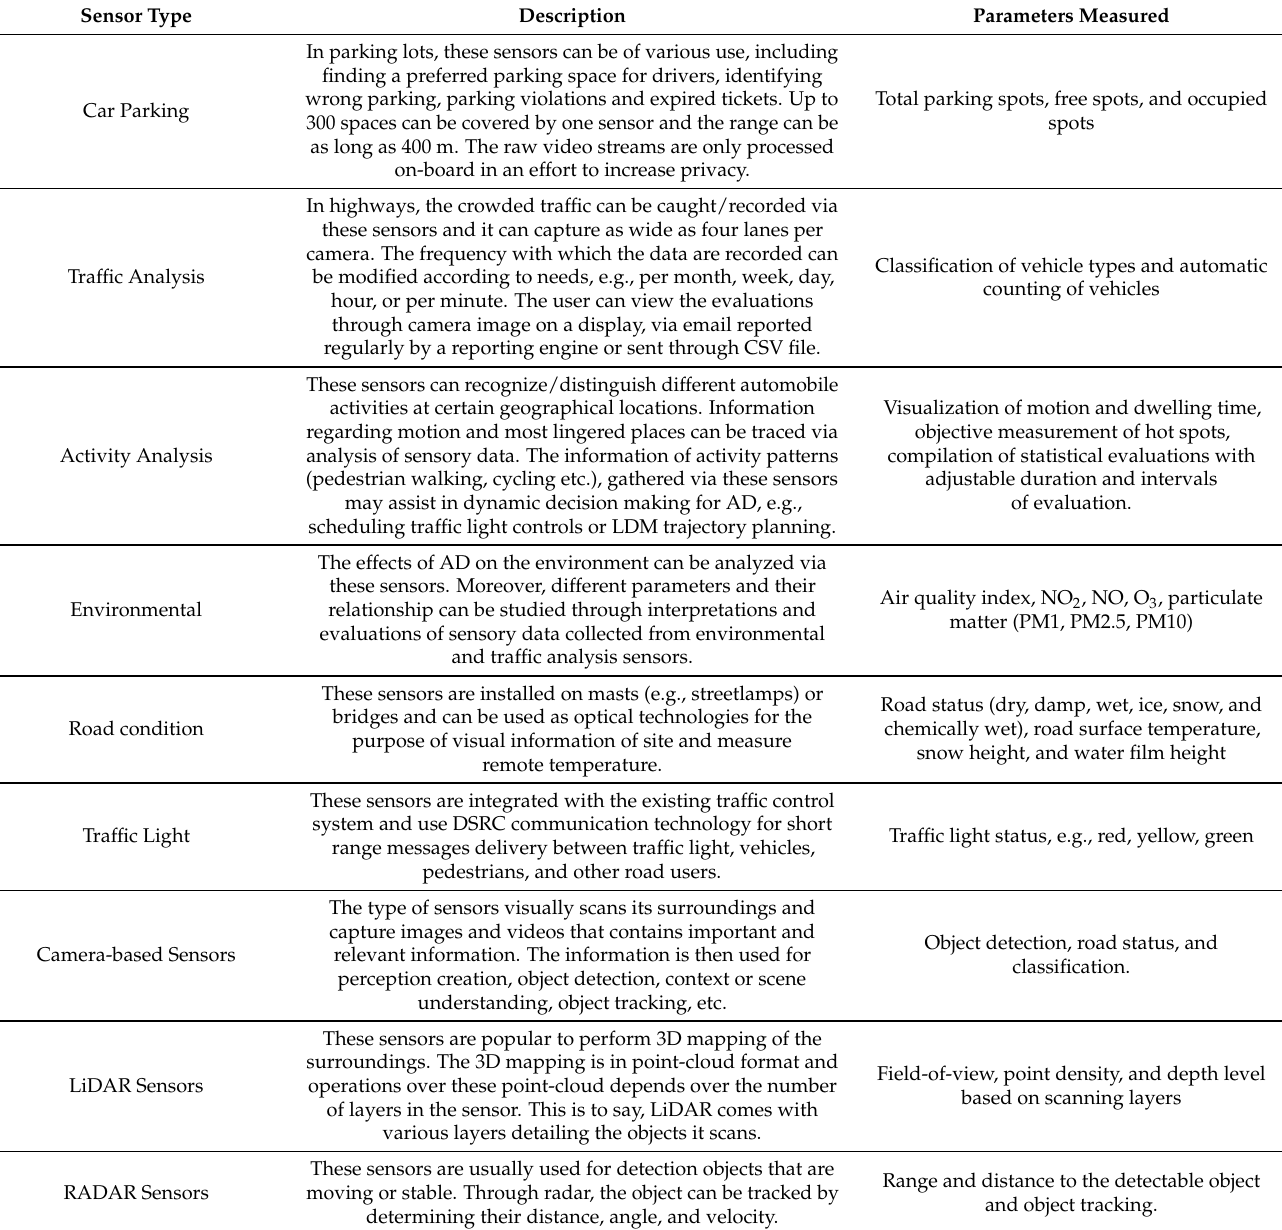
Table 2. Types and descriptions of the